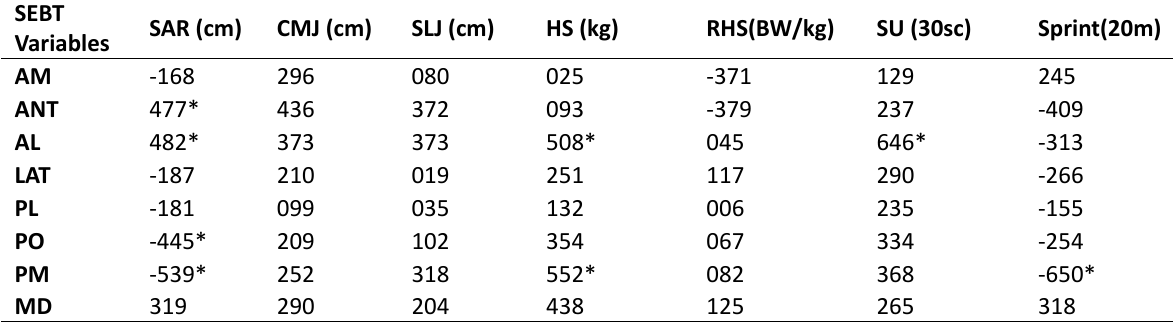
Relative Handgrip Strength, SU= Sit-ups Table 3. The correlations between dynamic balance and selected athletic performances SEBT